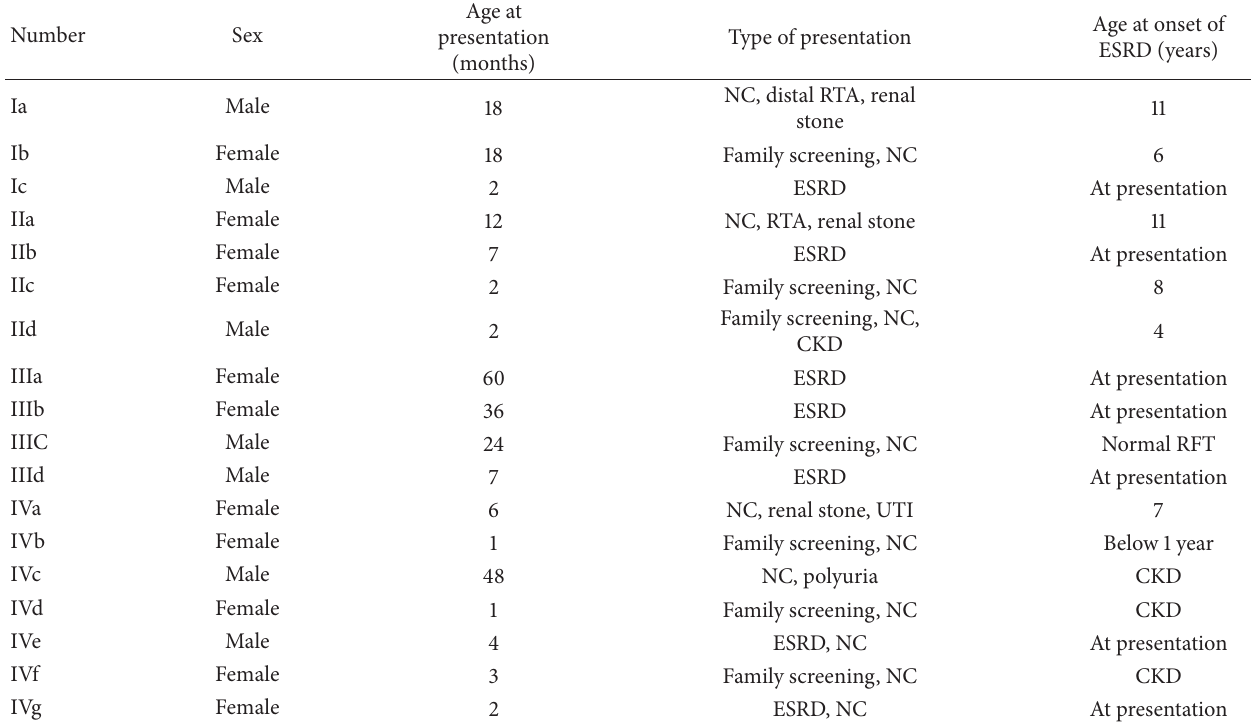
Table 1: Demographic data and clinical